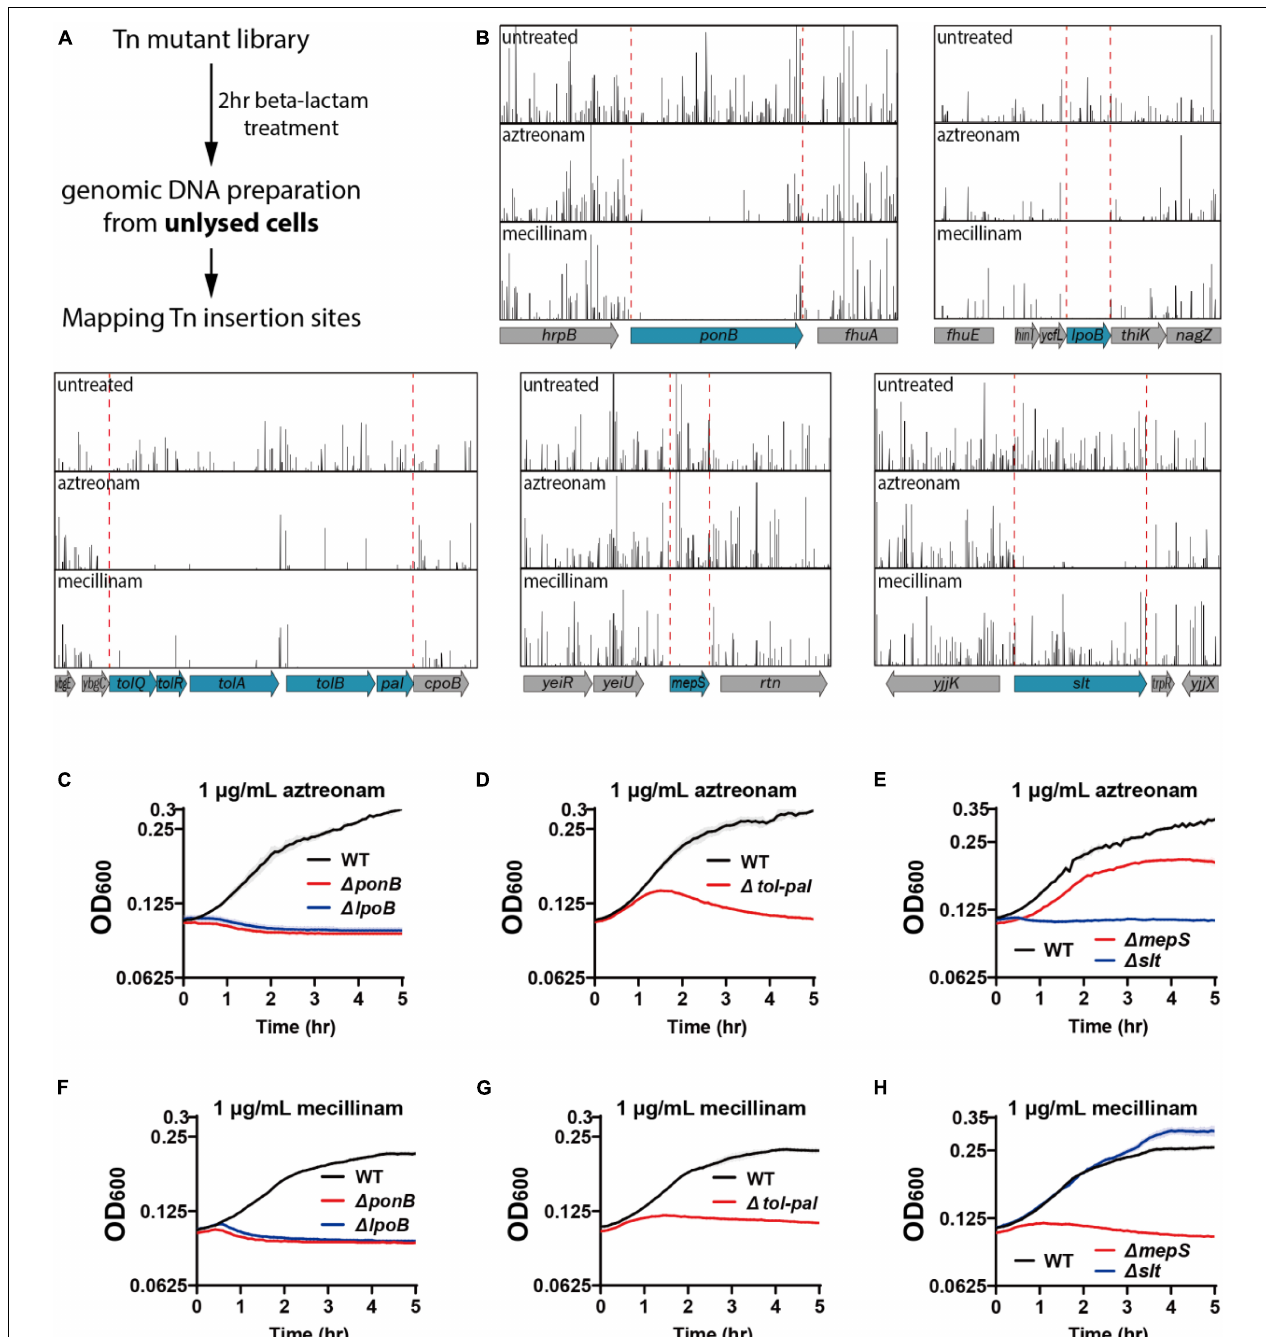
FIGURE 1 | Tn-seq-based screening of genes important for maintaining cell integrity. (A) Scheme of the transposon screen used to identify genes required for maintaining cell integrity upon beta lactam treatment. Cultures of an E. coli transposon mutant library were treated for 2 h with aztreonam or mecillinam that specifically target PBP3 or PBP2, respectively. Unlysed cells were collected after beta lactam treatment and the transposon insertion profiles were compared with that of the untreated library to identify mutations that cause rapid lysis upon beta lactam treatment. (B) Transposon insertion profiles of genomic regions near the genes that showed significant reduction in transposon insertion frequency. Each vertical line represents a sequenced insertion site and the heights of the lines represent the number of reads mapped at those sites. (C–H) Lysis curves of the mutant strains identified from the transposon screen. MG1655, WJ2 ( (cid:49) ponB ), SP38 ( (cid:49) lpoB ), SP10 ( (cid:49) tol-pal ), SP8 ( (cid:49) mepS ), and SP178 ( (cid:49) slt ) strains were grown overnight in LB at 30 ◦ C. The overnight cultures were diluted to an OD 600 of 0.02 in LB and grown to an OD 600 between 0.2 and 0.3. The exponential cultures were diluted to an OD 600 of 0.1 in LB containing either aztreonam (C–E) or mecillinam (F–H) at a final concentration of 1 µ g/ml and grown at 30 ◦ C. The optical density of the cultures was measured in triplicate in a 96-well microtiter plate for 5 h with agitation at 30 ◦ C after beta lactam treatment. The solid lines represent the means and the shades standard deviations.